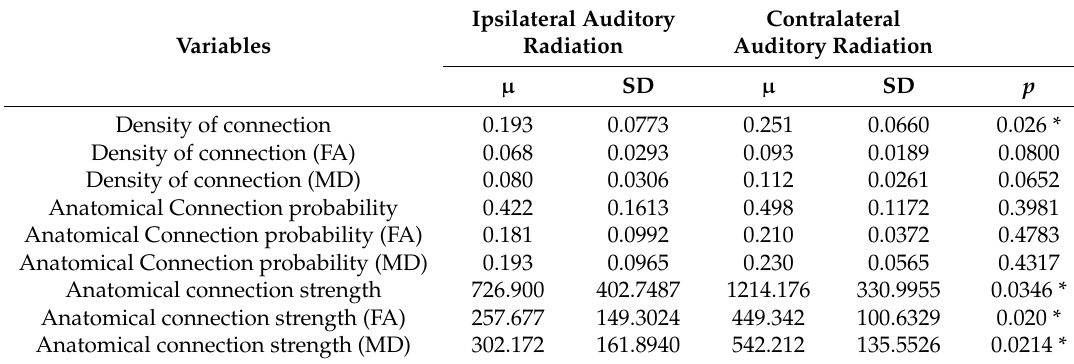
Table 3. Auditory radiations variables of DTI (Diffusion Tensor